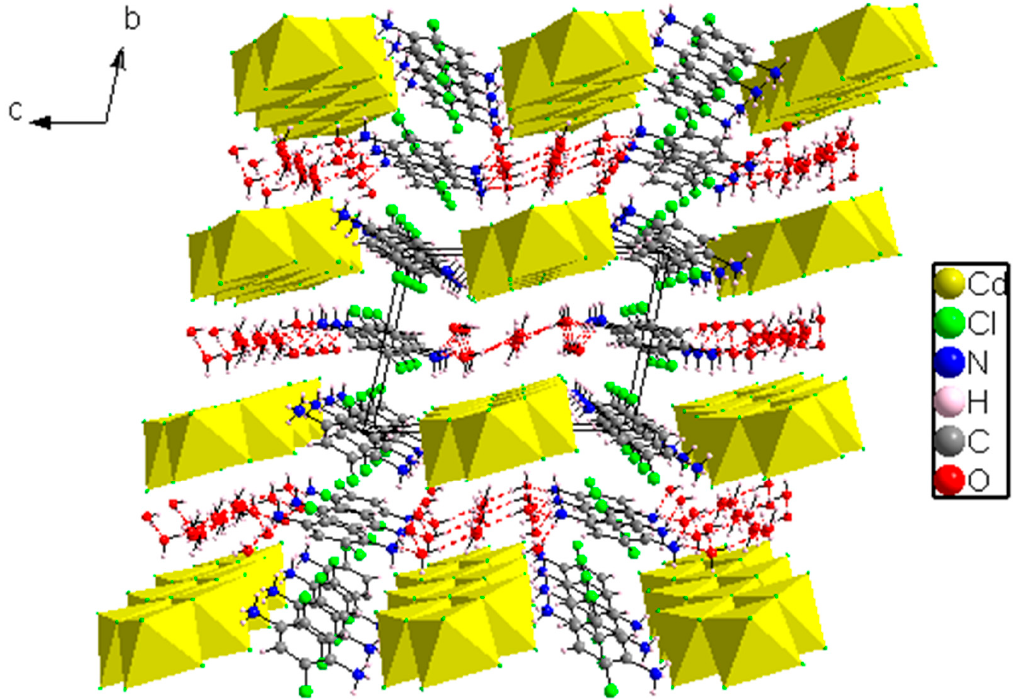
Figure 6. Perspectiveviewof (C 6 H 8 Cl 2 N 2 ) 2 [Cd 3 Cl 10 ] · 6H 2